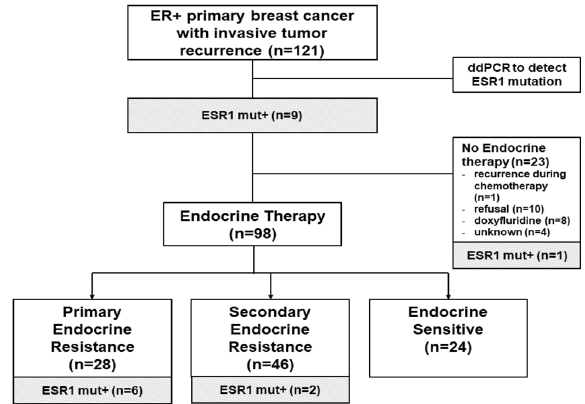
Fig. 1 Consort diagram. The de fi nitions of primary endocrine resistance, secondary endocrine resistance, and endocrine sensitiv- ity followed the 5th International Consensus Conference for Advanced Breast Cancer guidelines and are provided in the Patients and methods section.